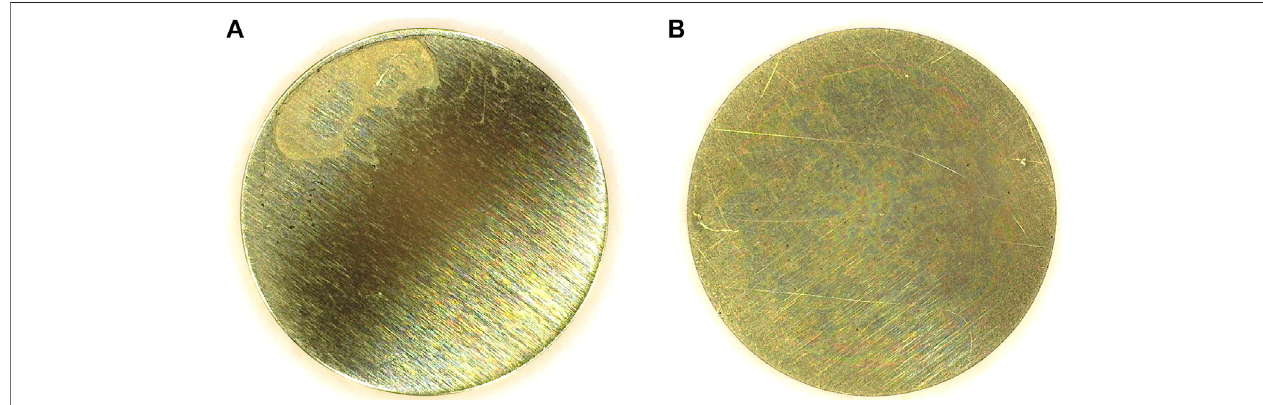
FIGURE 2 | Working electrodes coated with AA iridium to a loading of 17.8 µg Ir cm − 2 , (A) without and (B) with electrode rotation (Alia and Anderson, 2019). © The Electrochemical Society. Reproduced by permission of IOP Publishing. All rights reserved.